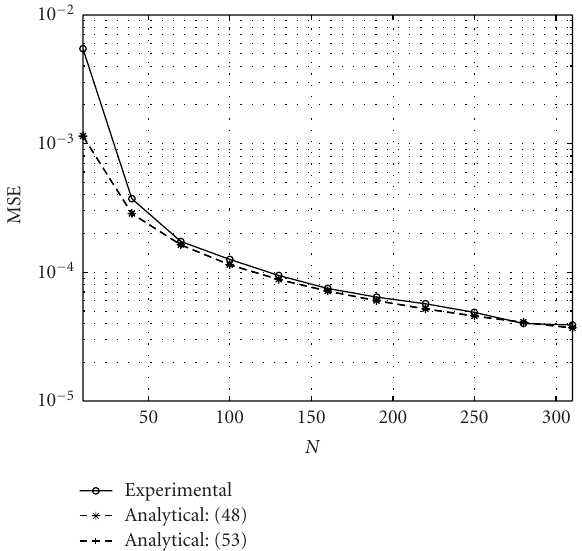
Figure 5: The MSE of the estimated channel versus number of data samples. The BP algorithm.